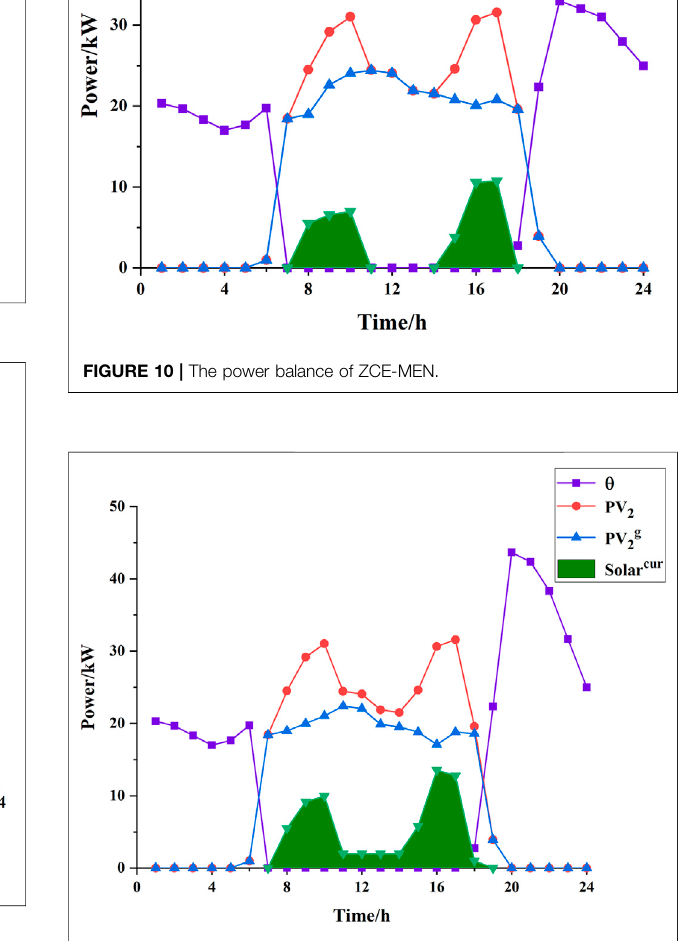
FIGURE 11 | The power balance of traditional